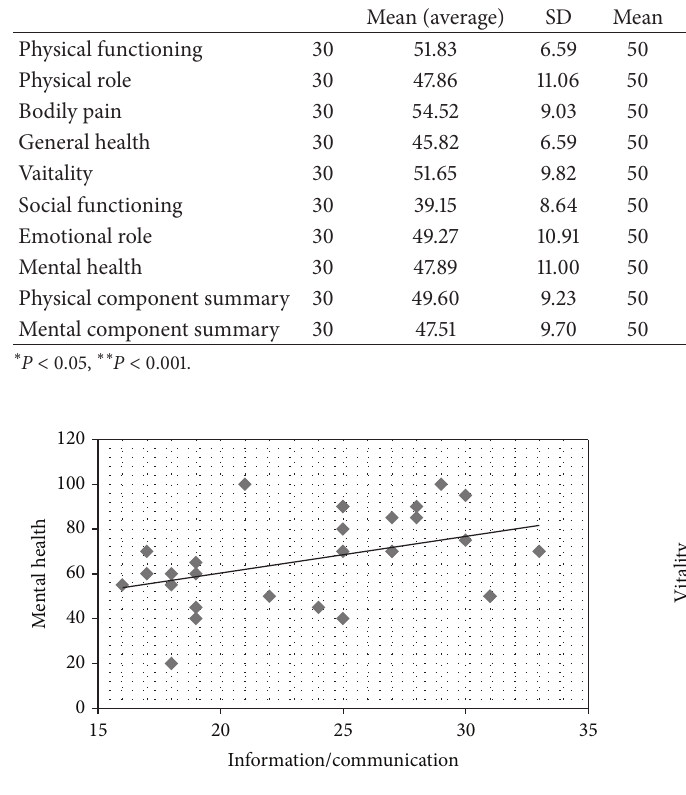
Figure 2: Correlation between vitality and information/communi- cation. 𝑟 = 0.374 , 𝑃 = 0.046 .